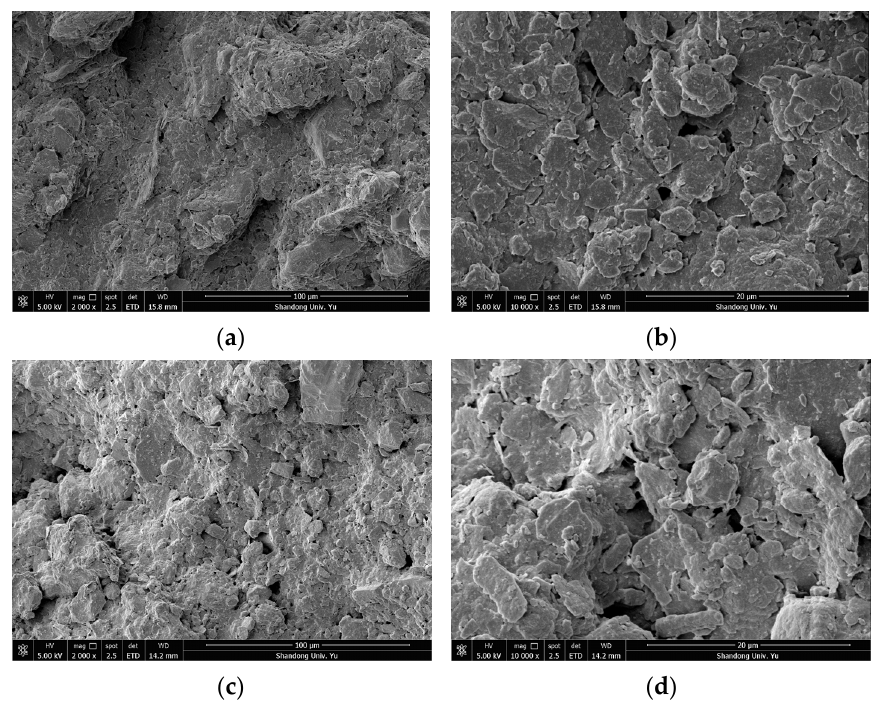
Figure 3. SEM images of the representative microstructure of the DK-9-10 group. ( a ) 2000 times, in the vertical direction; ( b ) 10,000 times, in the vertical direction; ( c ) 2000 times, in the horizontal direction; ( d ) 10,000 times, in the horizontal direction.